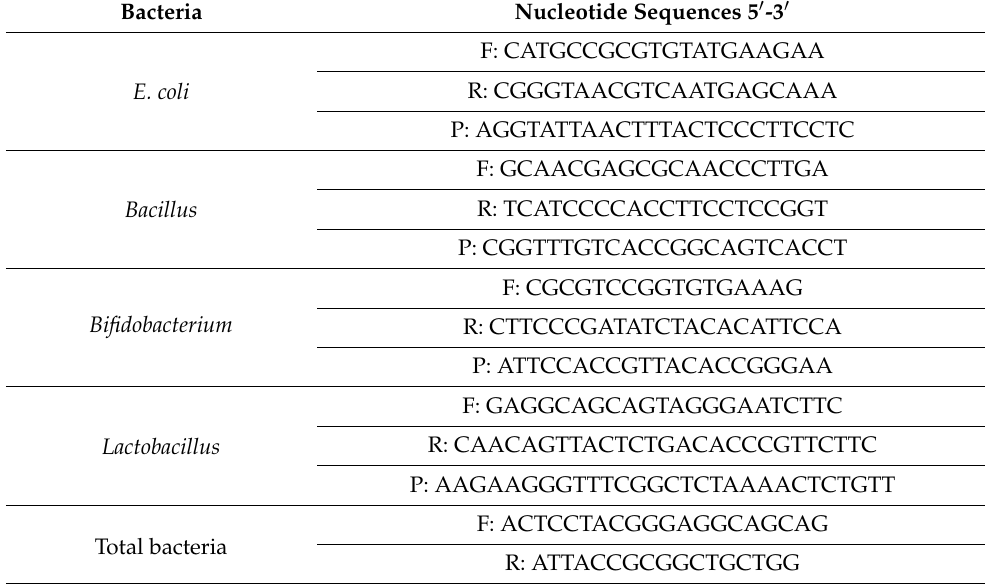
Table 3. Primer and probe sequences used for real-time